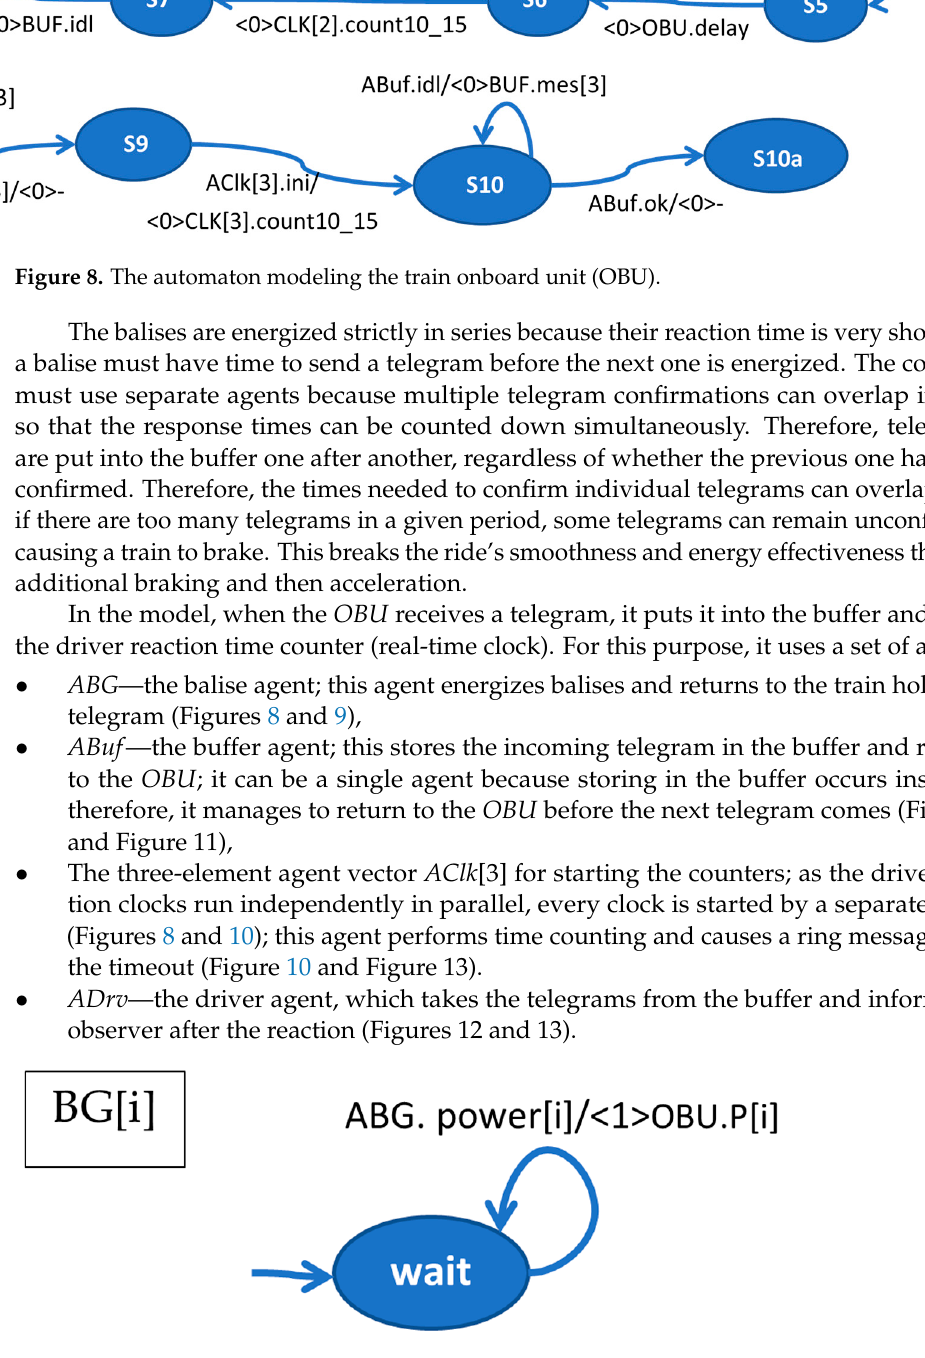
Figure 8. The automaton modeling the train onboard unit (OBU).